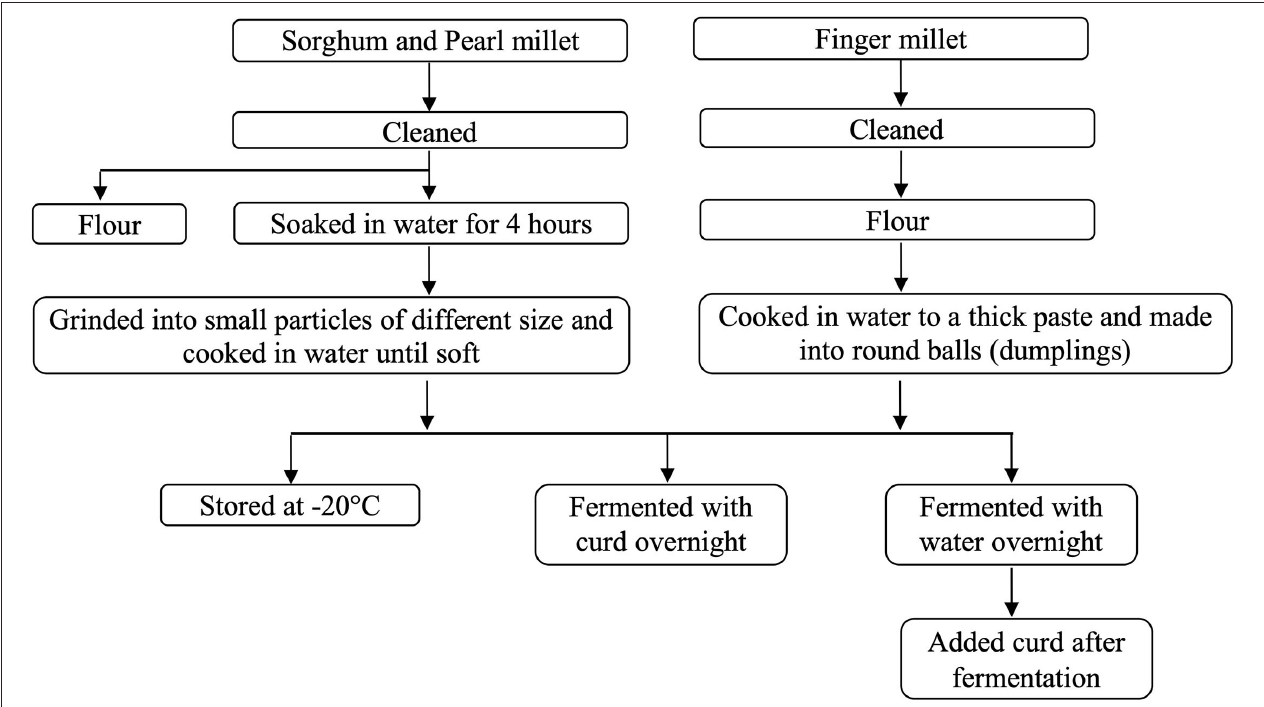
FIGURE 1 | Sample preparation flow